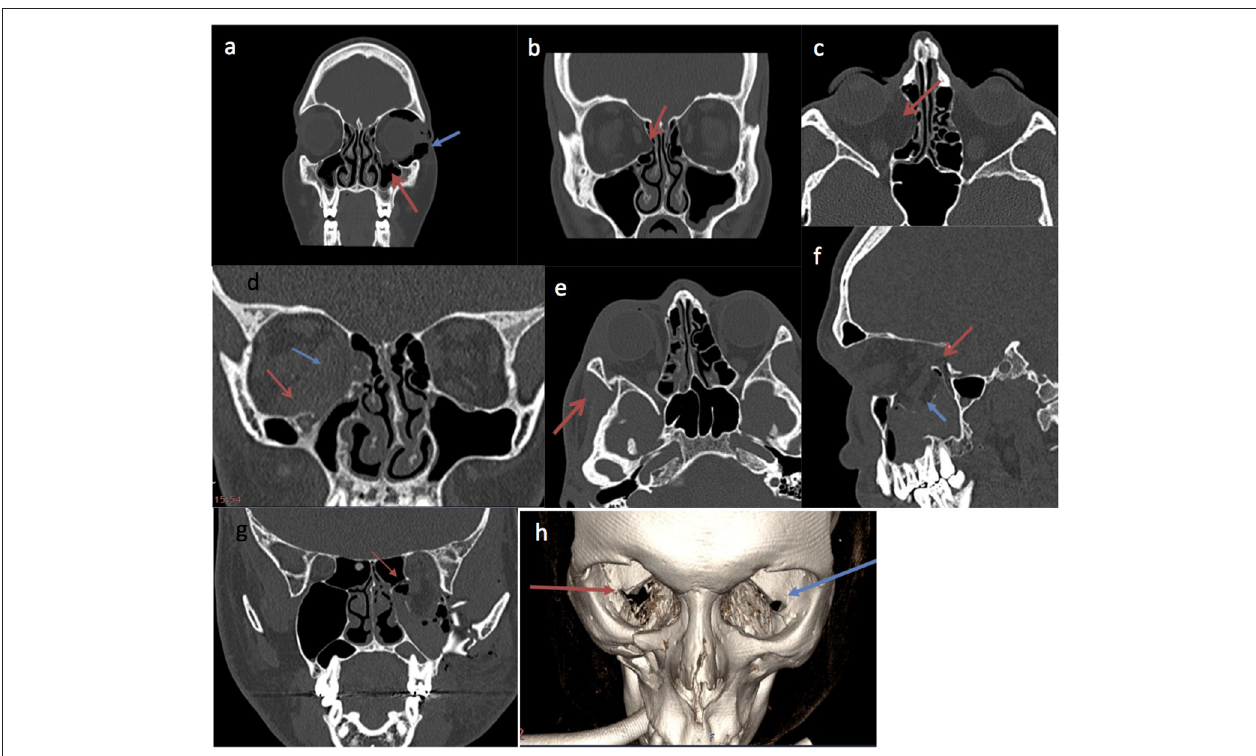
FIGURE 1 | Pre-operative CT imaging examples of fracture parameters used in analysis. (a) Coronal slice of facial bones CT showing an isolated left orbital floor fracture (red arrow) associated with orbital emphysema (blue arrow). (b) Coronal slice of a facial bone CT demonstrating isolated right medial orbital wall fracture (red arrow). (c) Axial slice of a right isolated medial wall fracture on CT orbit (red arrow). (d) Coronal slice of facial bones CT showing right medial wall and right floor fracture. The red arrow points to a right orbital floor fracture. The blue arrow demonstrates right medial wall fracture. (e) Right lateral wall fracture (red arrow) on CT orbits. (f) Sagittal slice of a facial bones CT image demonstrating orbital floor fracture of > 50% (blue arrow). The red arrow shows insufficient intact posterior ledge enough to support a plate, making surgical repair more challenging. (g) Coronal slice of facial bones CT showing left orbital floor and medial wall fracture. The red arrow demonstrates the involvement of the posterior medial bulge. (h) 3D image reconstruction of facial bones CT, the red arrow shows the involved inferior orbital fissure of the right orbital fracture. The blue arrow shows the intact left inferior orbital